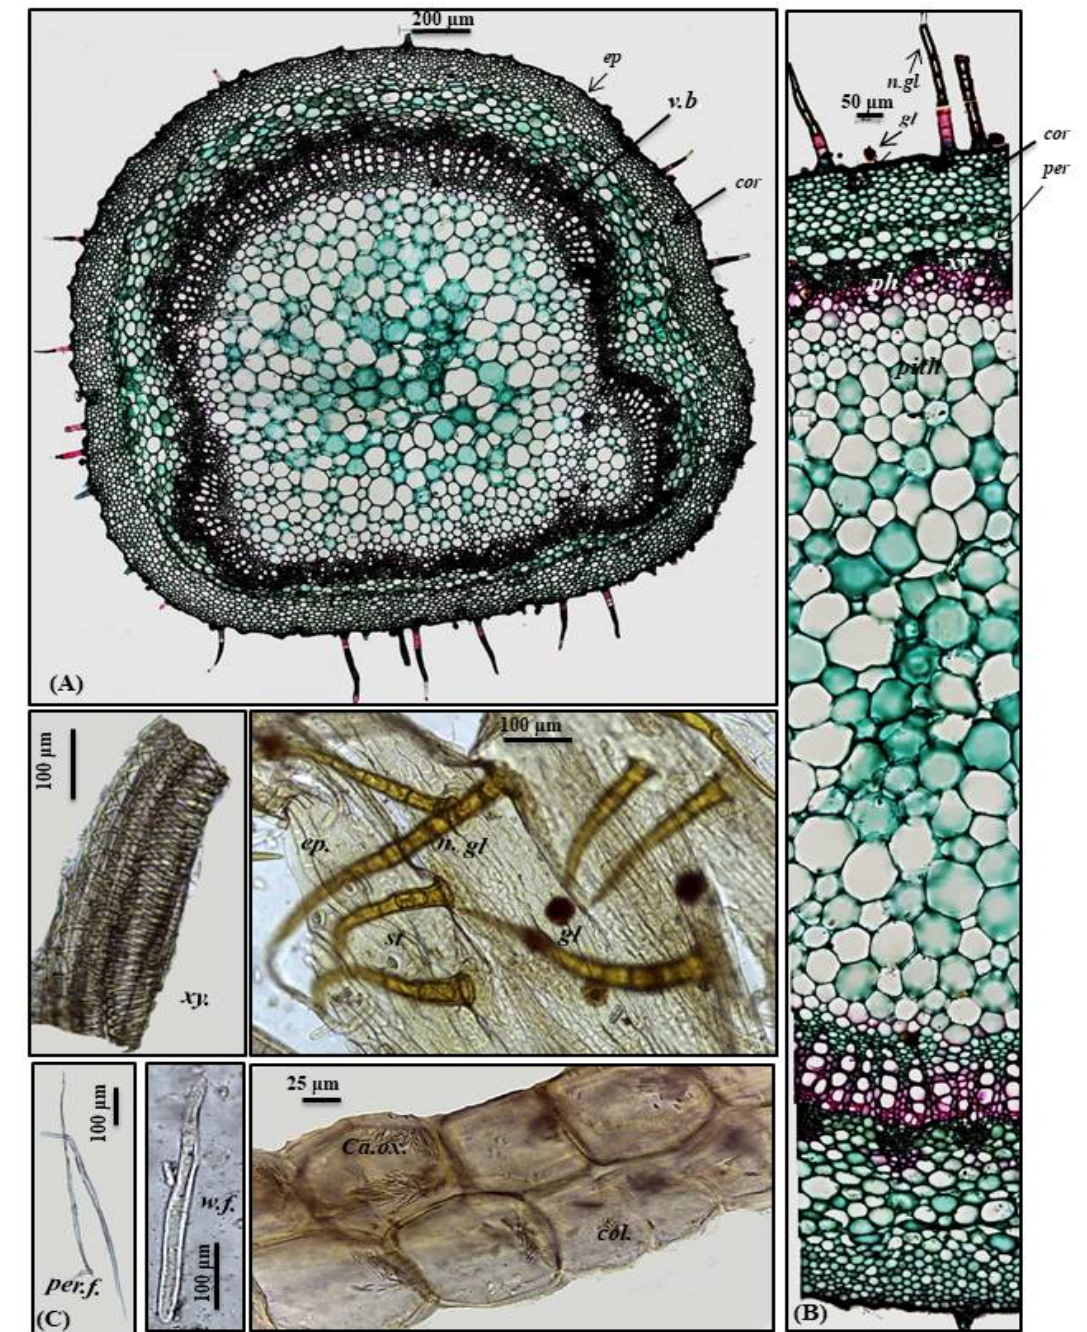
Figure 3. Micromorphology of P. odorata petiole showing ( A ) entire T.S (×100), ( B ) a part of T.S (×400) and ( C ) isolated elements. Ca.ox. , acicular crystals of calcium oxalate; cor. , cortex; col. , collenchyma; ep. , epidermis ; gl. , glandular peltate trichome ; n . gl., non ‐ glandular trichome ; per ., pericycle; per.f., pericycle fiber; ph ., phloem; v.b , vascular bundle; w.f., wood fiber; xy ., xylem.